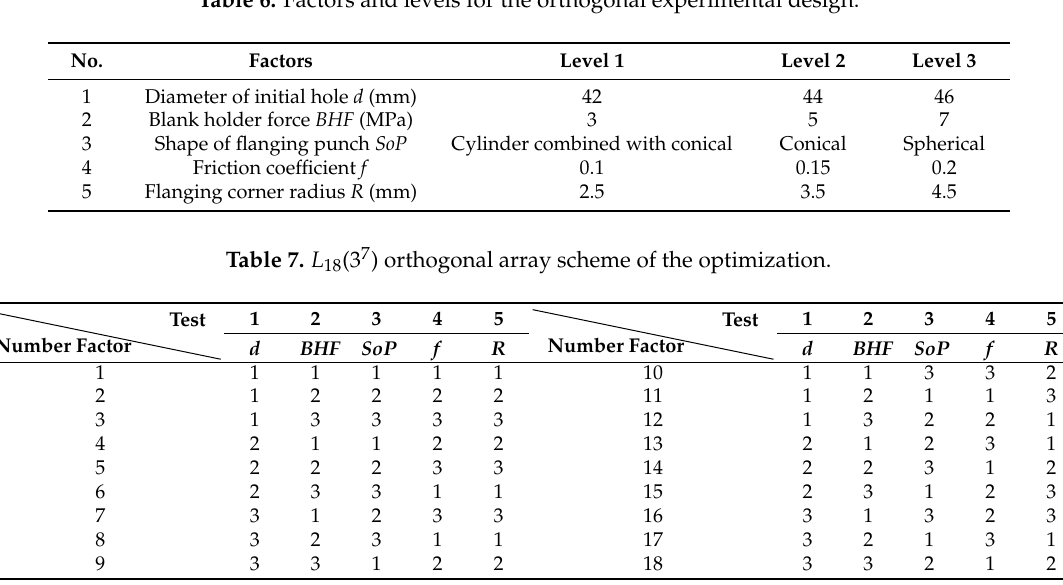
Figure 8. Illustrations of different shapes of flanging punch: ( a ) cylinder combined with conical; ( b ) conical; ( c ) spherical. Table 6. Factors and levels for the orthogonal experimental design.